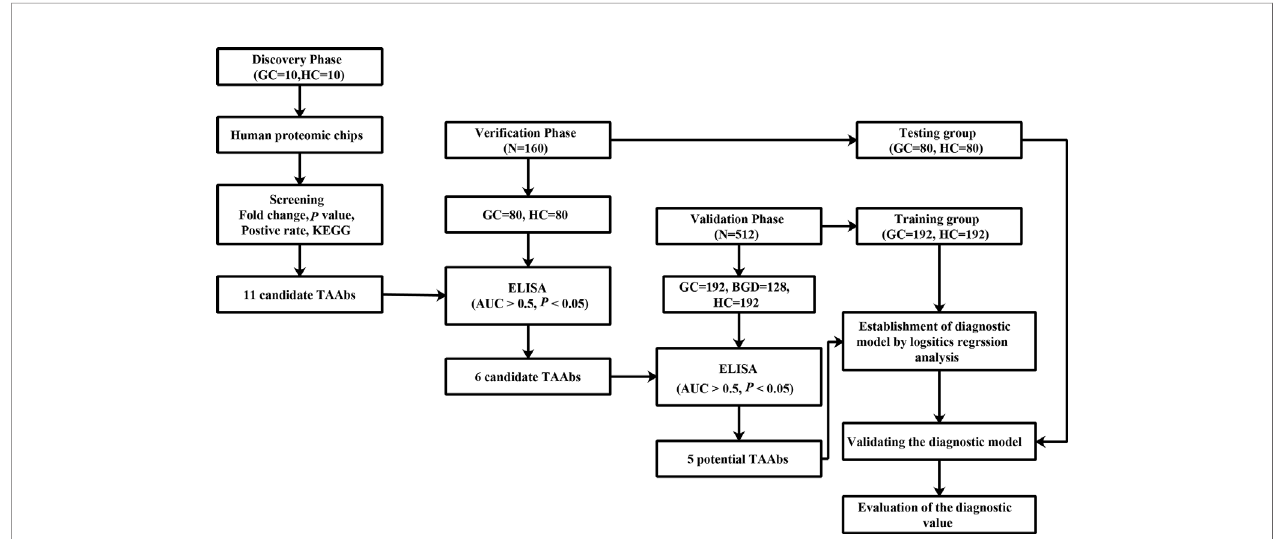
FIGURE 1 | The design of this study. GC, gastric cancer; HCs, healthy controls; ELISA, enzyme-linked immunosorbent